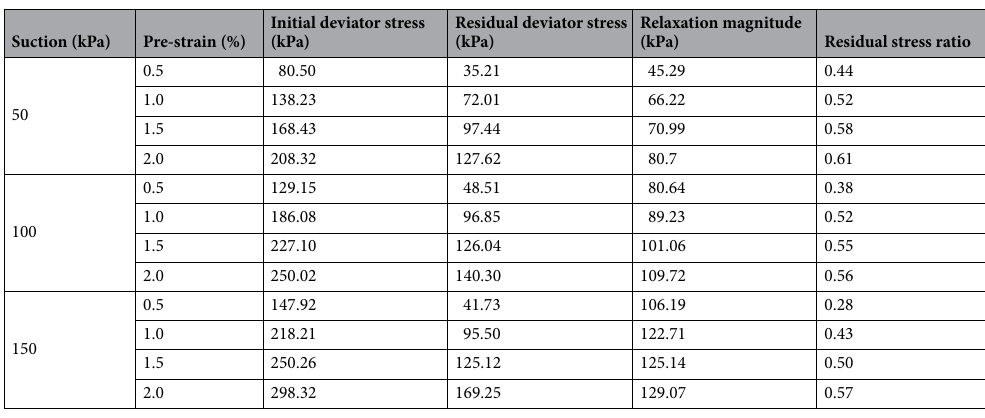
Table 5. Characterization parameters of stress relaxation.